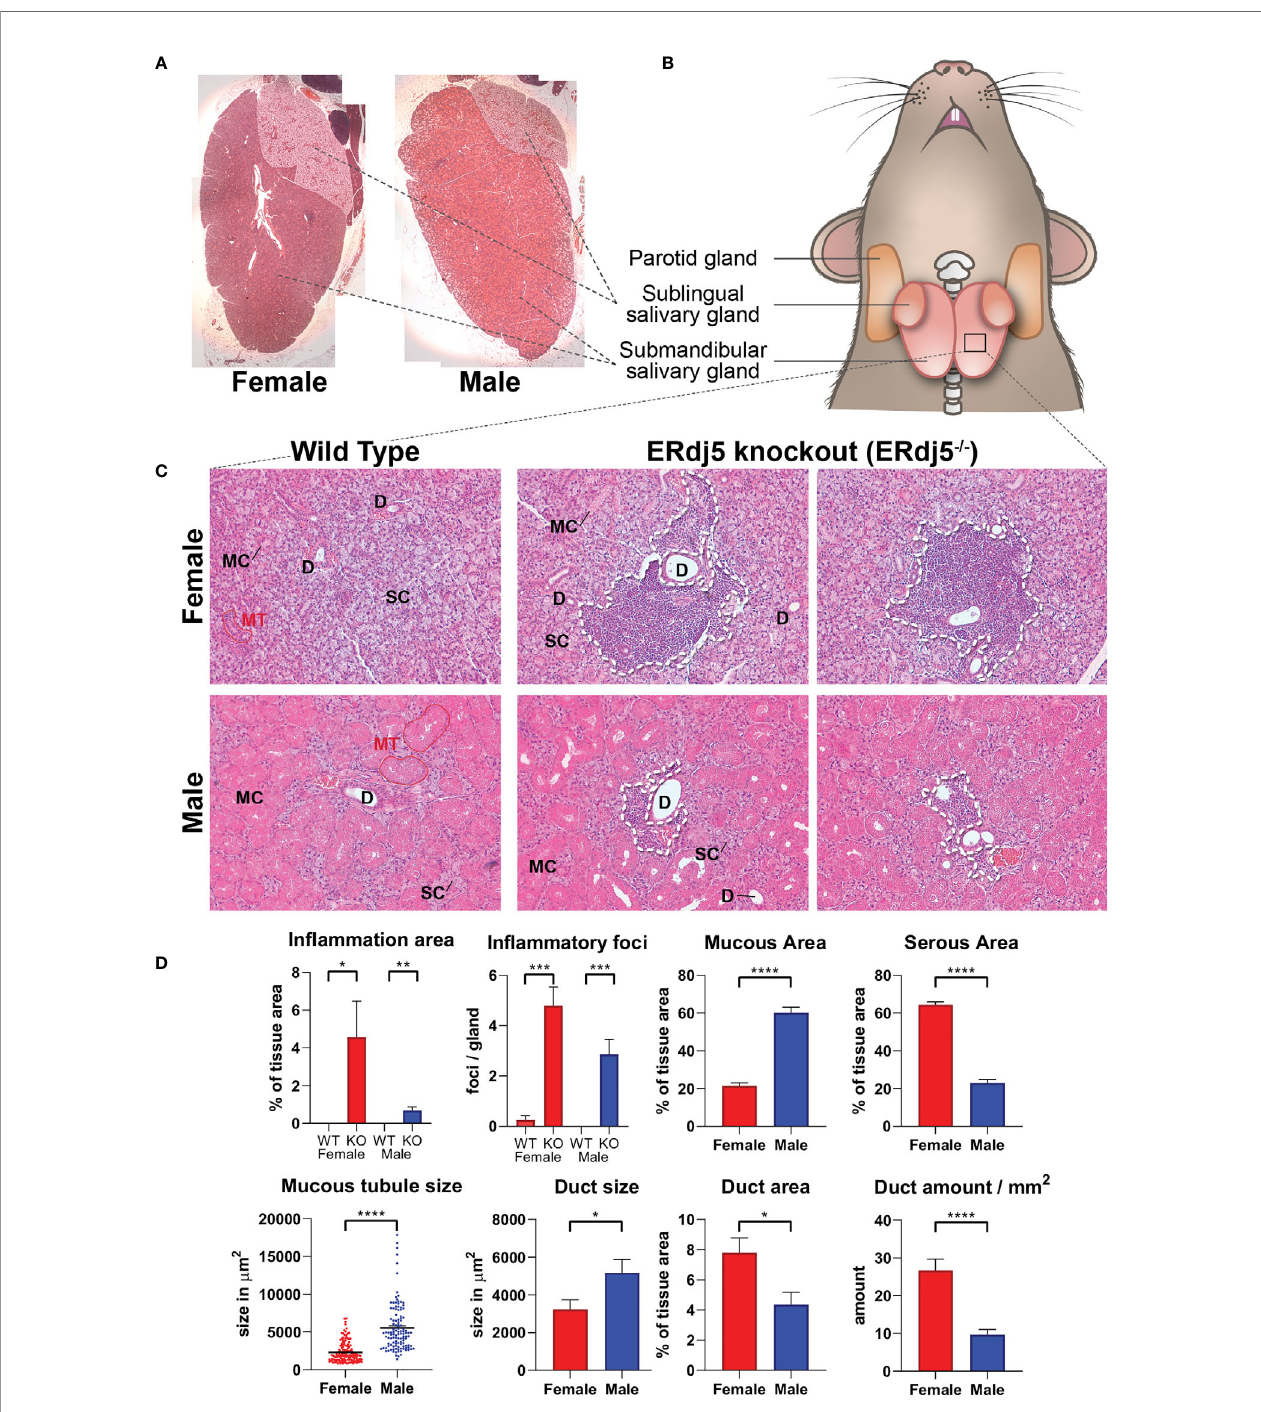
FIGURE 1 | Histological image of mouse submandibular salivary glands and the in fl ammatory in fi ltrations in ERdj5 knockout mice. H+E stain. (A) Low magni fi cation reconstruction of whole sublingual (top right side)/submandibular (main tissue) gland sections, illustrating the macroscopic differences between males and females. Original magni fi cation: 25x. (B) Graphical representation of tissue samples. (C) Representative images for all study animals (n=6) under microscopic examination of submandibular gland features. Top Row: Female mice 7 months old. Bottom row: Male mice 7 months old. In fl ammatory regions in KO mice are circumscribed with a dashed line. SC: serous cells, MC: mucous cells, D: ductal area, MT: mucous tubule. Original magni fi cation: 200x. (D) Morphometric analysis. For in fl ammatory information, all tissue area of all animals was examined. For mucous/serous/ductal area quanti fi cation, 3 randomly selected microscopic frames were analysed and measured per study animal. For tubule size, 119 (from all male animals) and 153 (for female animals) tubules were measured. Data are presented as mean values ± SEM. Statistically signi fi cant differences according to t-test are indicated as *p < 0.05, **p < 0.01, ***p < 0.001 and ****p <